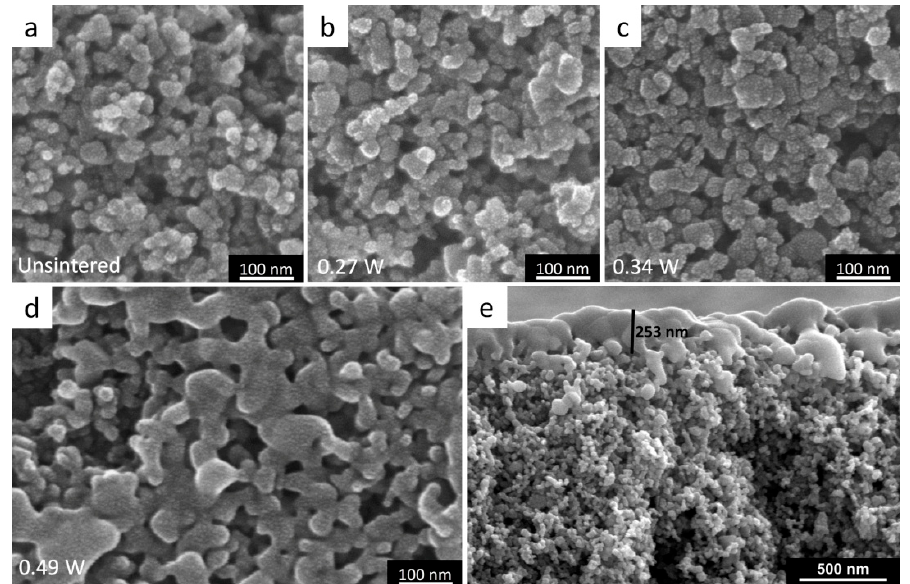
Figure 2. Scanning electron microscope (SEM) images of ( a ) original TiO 2 film, ultraviolet (UV) laser sintered TiO 2 films with the laser fluence of ( b ) 0.22 J/cm 2 , ( c ) 0.28 J/cm 2 , and ( d ) 0.4 J/cm 2 , ( e ) section image of laser sintered TiO 2 film with the laser fluence of 0.4 J/cm 2 .